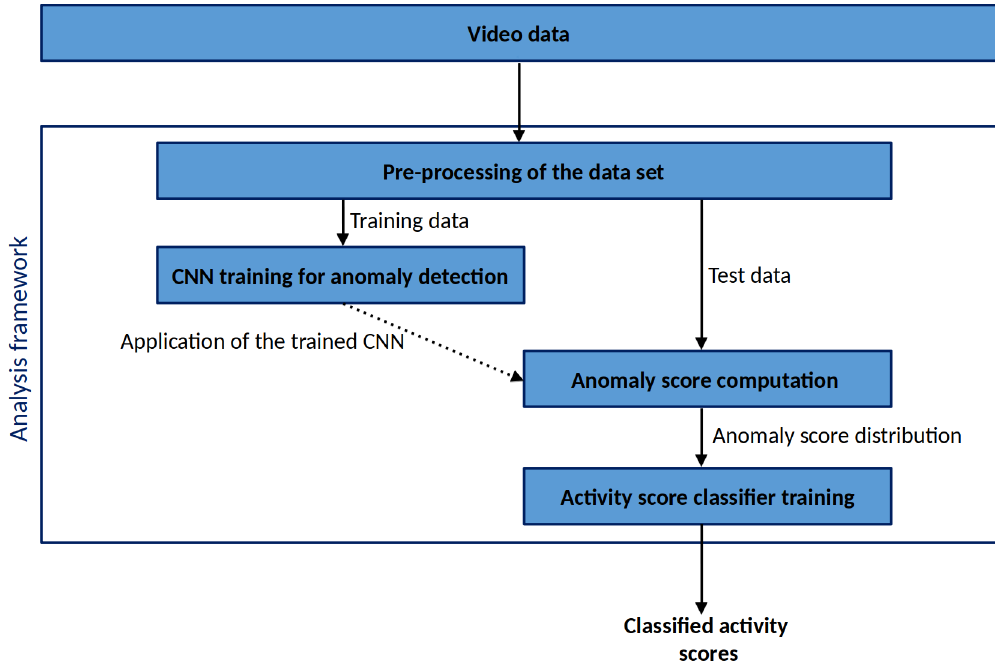
Figure 1. Flowchart of the analysis applied in this study.